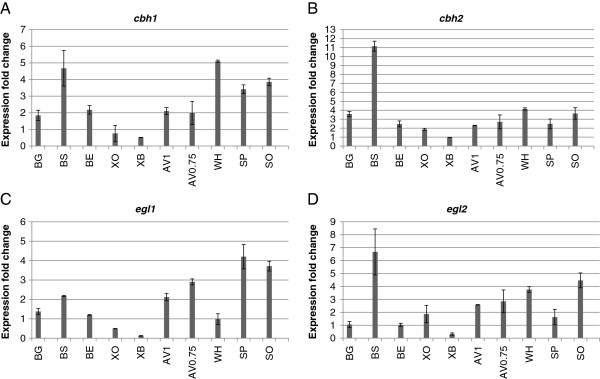
Quantitative PCR analysis of highly expressed genes. Samples collected at 17 h time point of induction were subjected to the qPCR analysis. The expression levels normalised with gpd1 signal are shown in the graphs as a fold change as compared to the uninduced control cultures at the same time point. The values are means of two biological replicates, and the error bars indicate standard deviation. (A) Expression of cbh1, cellobiohydrolase 1; (B) expression of cbh2, cellobiohydrolase 2; (C) expression of egl1, endoglucanase 1; (D) expression of egl2, endoglucanase 2.